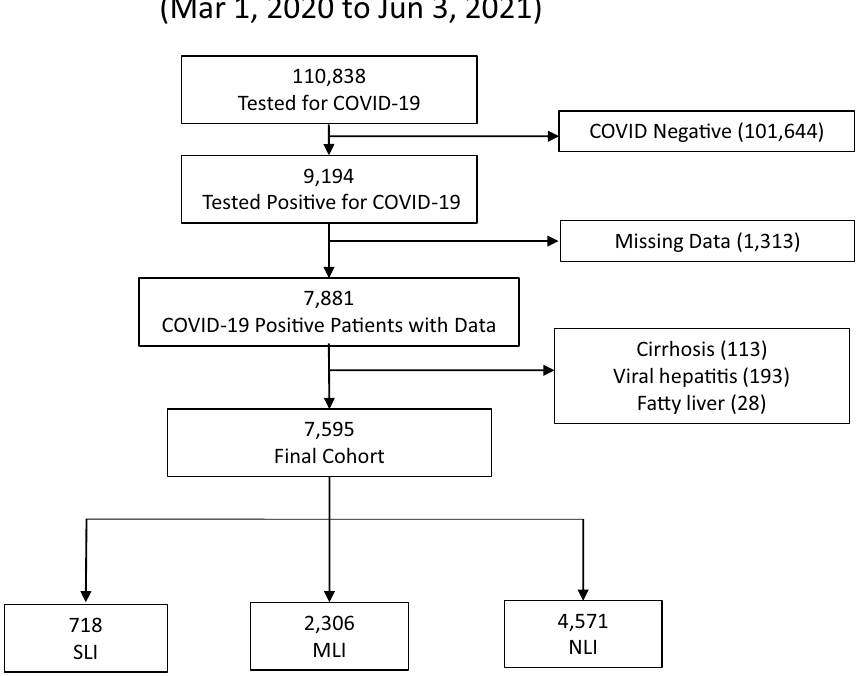
Figure 1. Flowchart of hospitalized patient selection. From March 11, 2020 to June 3, 2021, there were a total of 110,838 hospitalized patients had tests for COVID-19 and 9194 had a positive COVID-19